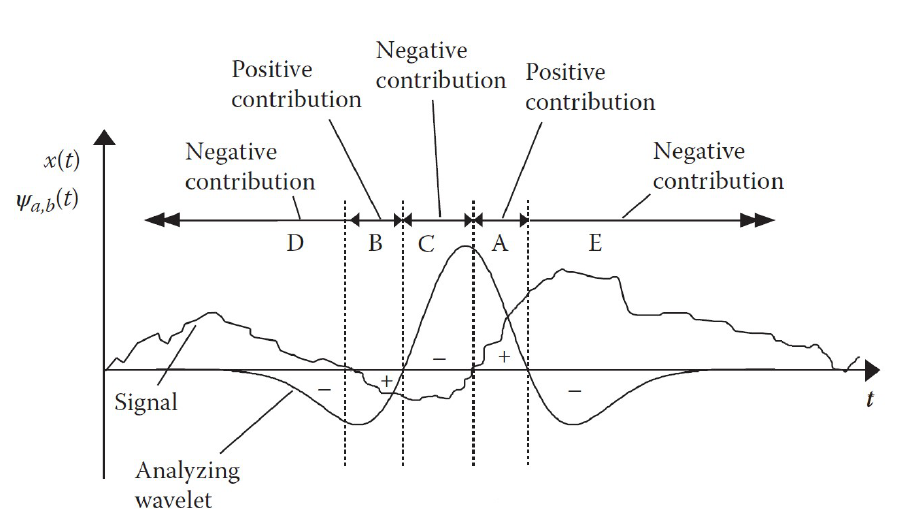
Figure 2. Shapes of different wavelet transform families.